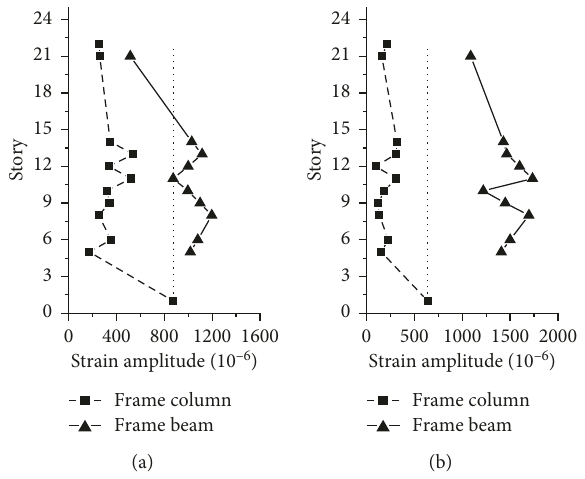
Figure 14: Comparison of strains in frame beam and frame column under rare earthquake. (a) Normative model; (b) optimization model.